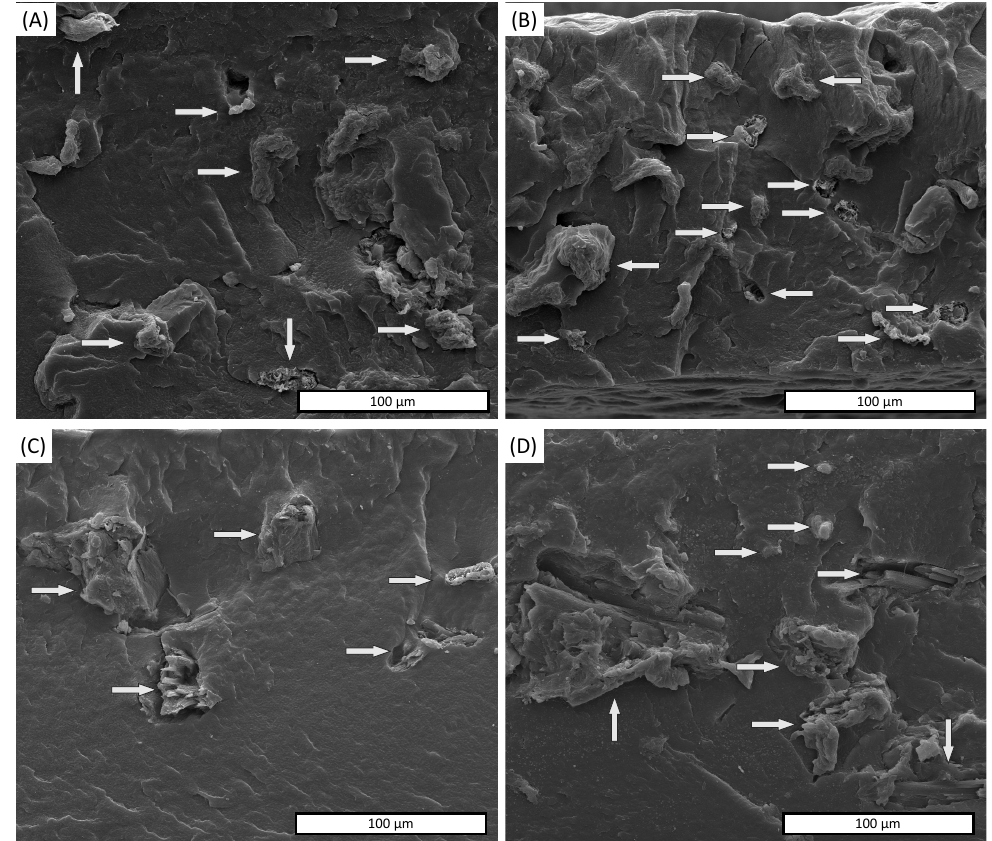
Figure 5. SEM images of the fractures surface of ( A ) PBAT/as-MCC 10%, ( B ) PBAT/as-MCC 20%, ( C ) PBAT/c-MCC 10%, ( D ) PBAT/c-MCC 20%.